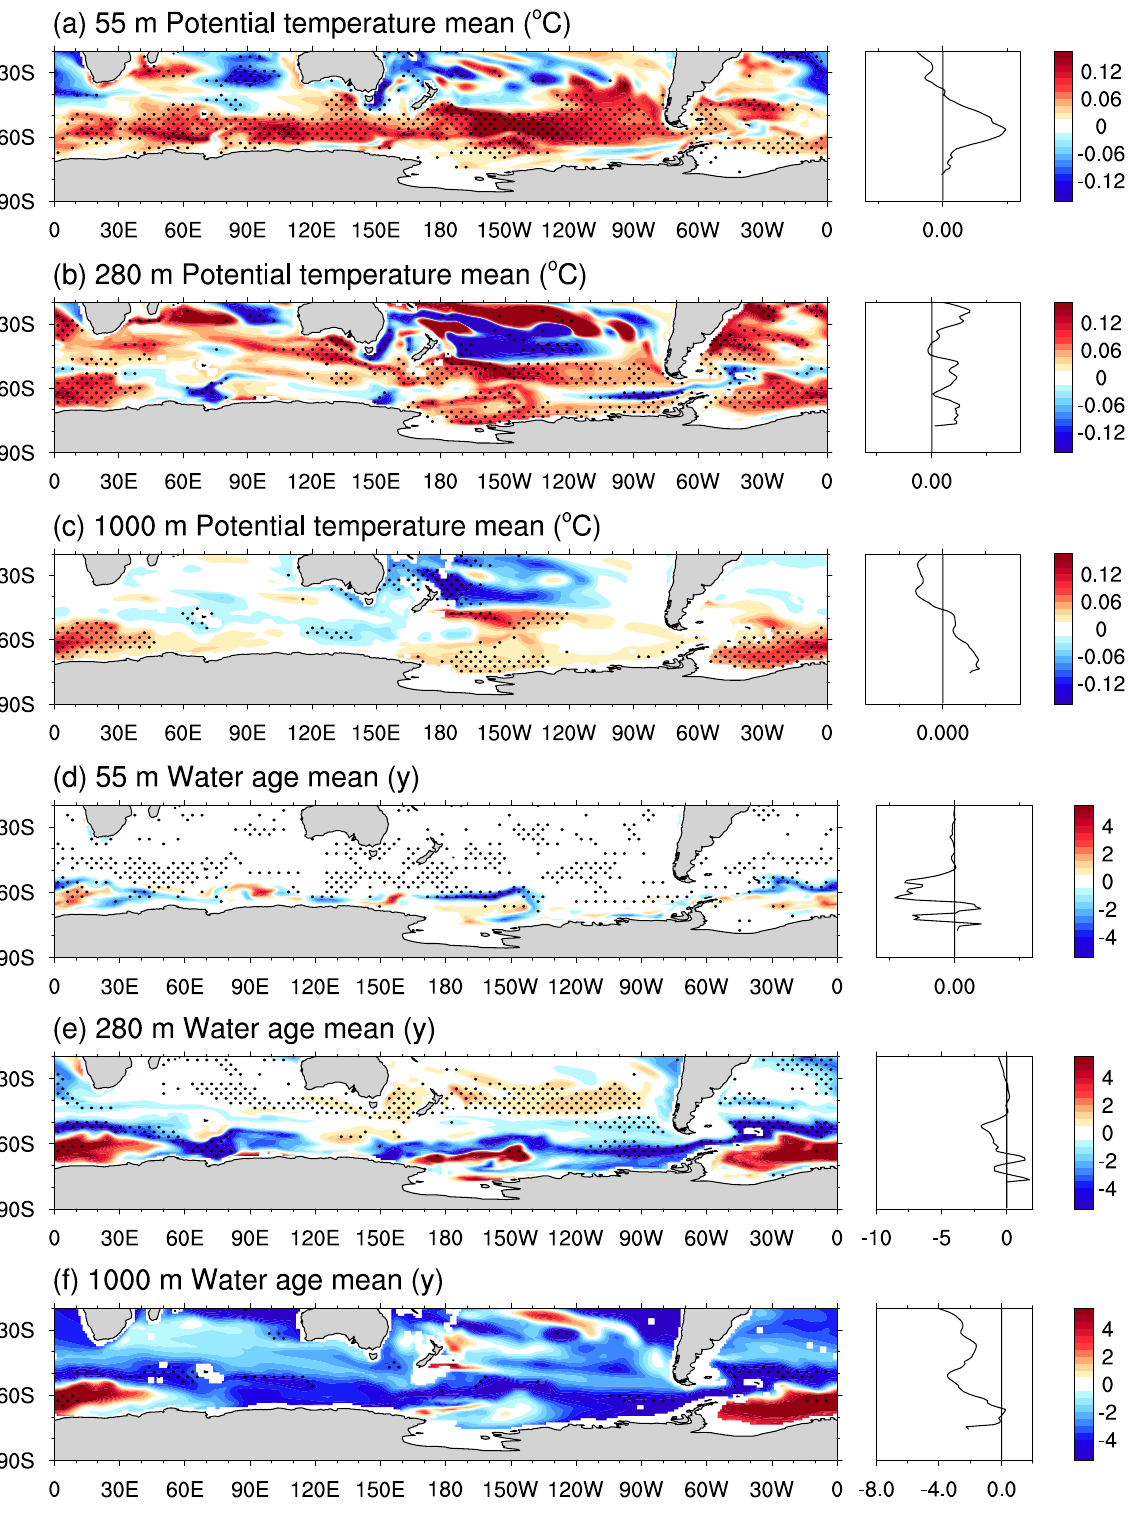
Figure 4. As for Fig. 1, but for annual-mean mean-state differences in: ( a , b , c ) potential temperature at 55 m, 280 m and 1000 m, respectively, and ( d , e , f ) water age at 55 m, 280 m and 1000 m, respectively. Figure produced using the NCAR Command Language (https:// doi. org/ 10. 5065/ D6WD3